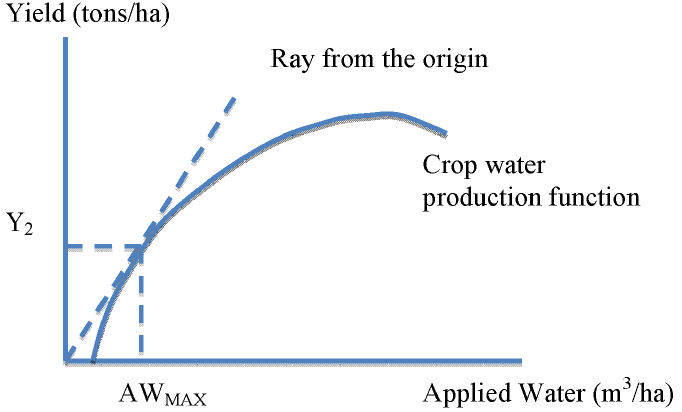
Figure 2. Depicting the maximum value of the water productivity of applied